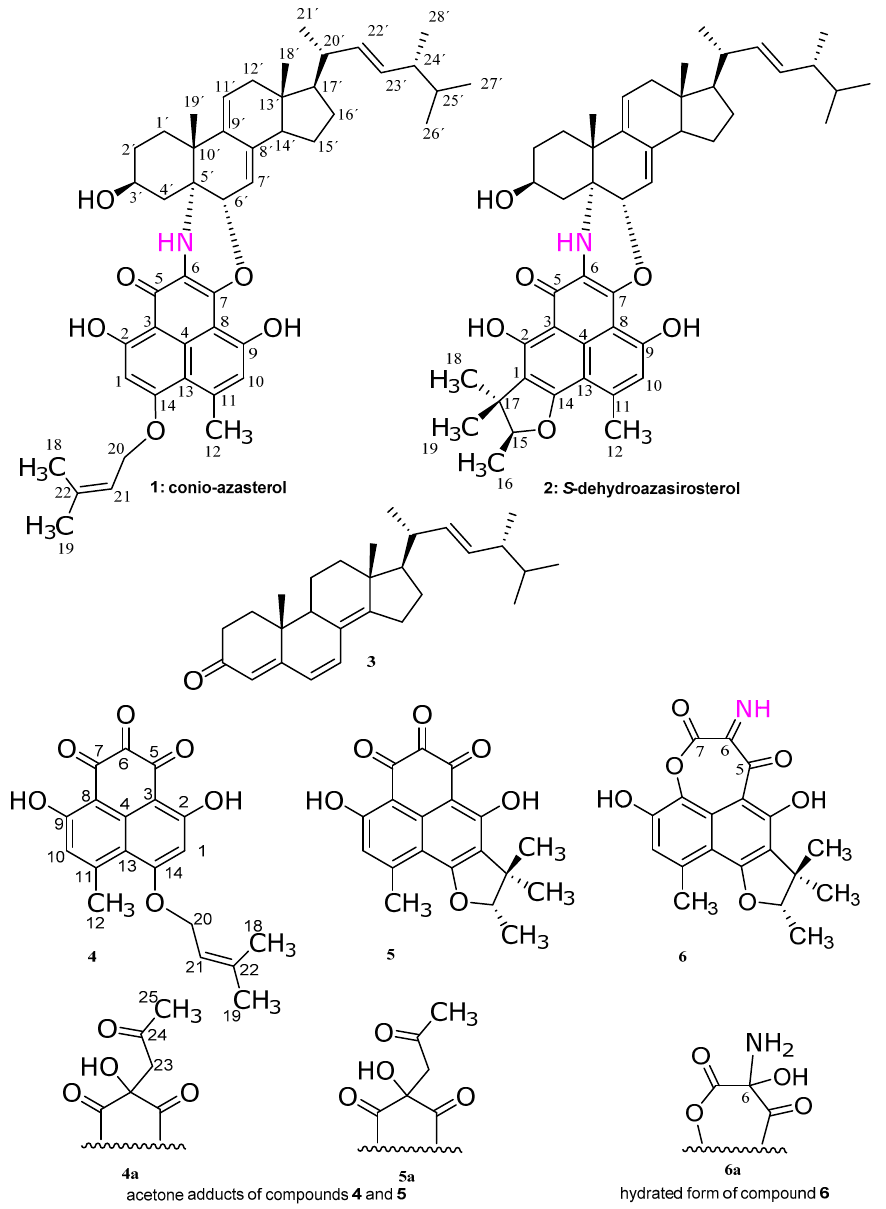
Figure 1. Chemical structures of the secondary metabolites 1 – 6 isolated from Coniothyrium cereale